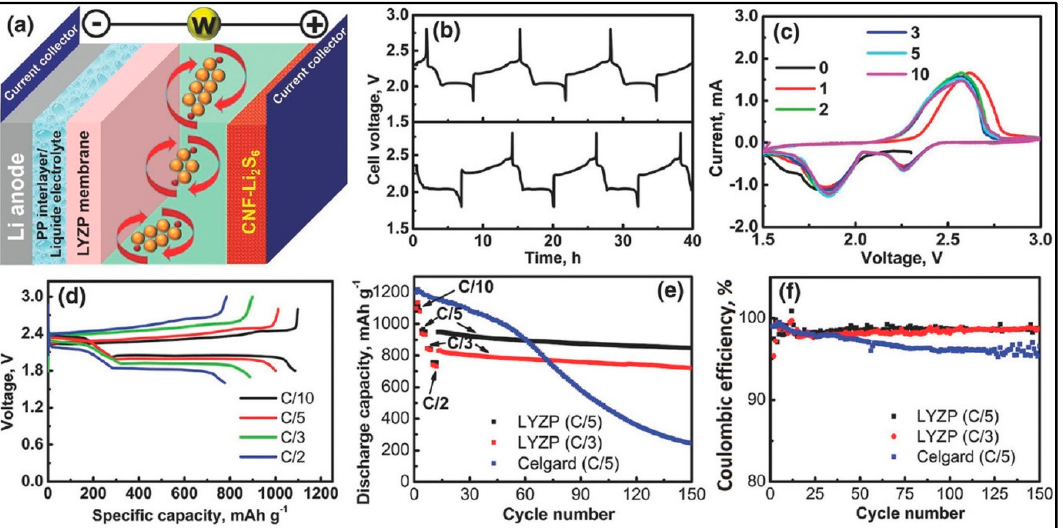
Figure 7. ( a ) Schematic representation of the all-solid-state lithium sulfur cell with NASICON-type (Li 1+x Y x Zr 2-x (PO 4 ) 3 membrane as a solid electrolyte/separator; ( b ) voltage versus time charge/dis- charge curve; ( c ) cyclic voltammetry of the cell; ( d ) galvanostatic charge/discharge curve; ( e ) dis- charge capacity versus number of cycle; ( f ) coulombic efficiency versus number of cycle. (Reprinted with permission from [123]; Copyright 2016, Adv. Energy Mater. 2016 , 6 .)